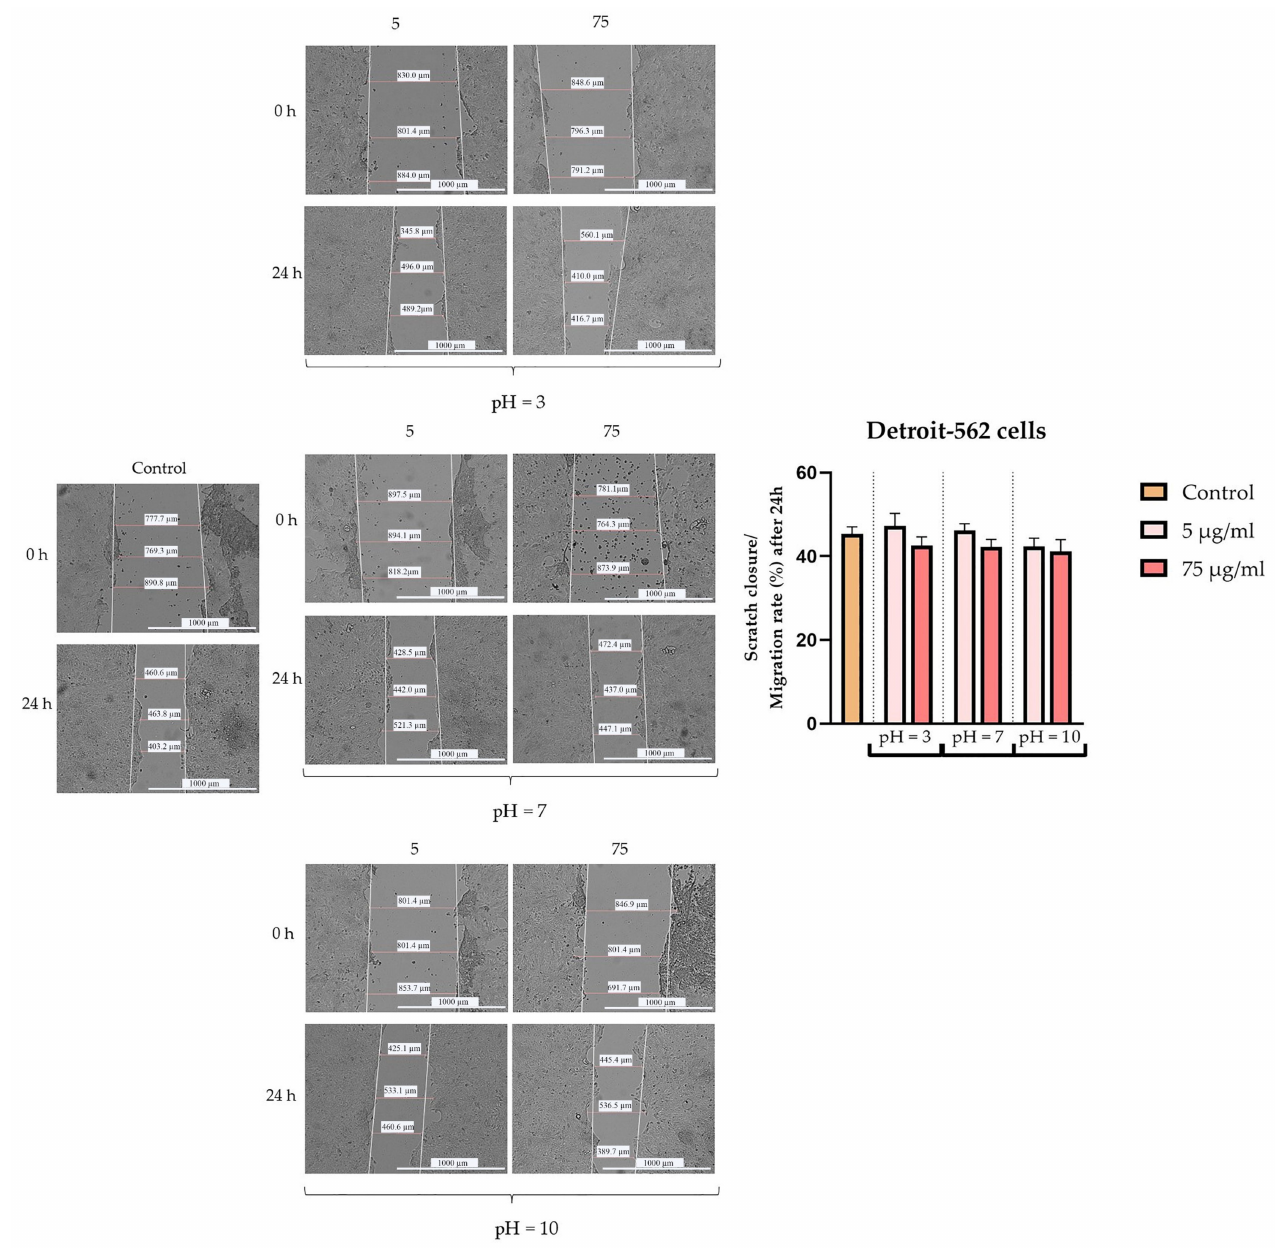
Figure 6. Scratch closure rate of Detroit-562 cells following P2 treatment (5 and 75 µ g/mL) in artificial saliva with three types of pH (acid, neutral, and basic). The bar graphs are presented as wound closure percentage after 24 h compared to the initial surface. The data are expressed as mean values ± SD of three independent experiments performed in triplicate. The statistical differences between the control and the P2-treated groups were identified by applying one-way ANOVA followed by the Dunnett’s multiple comparisons